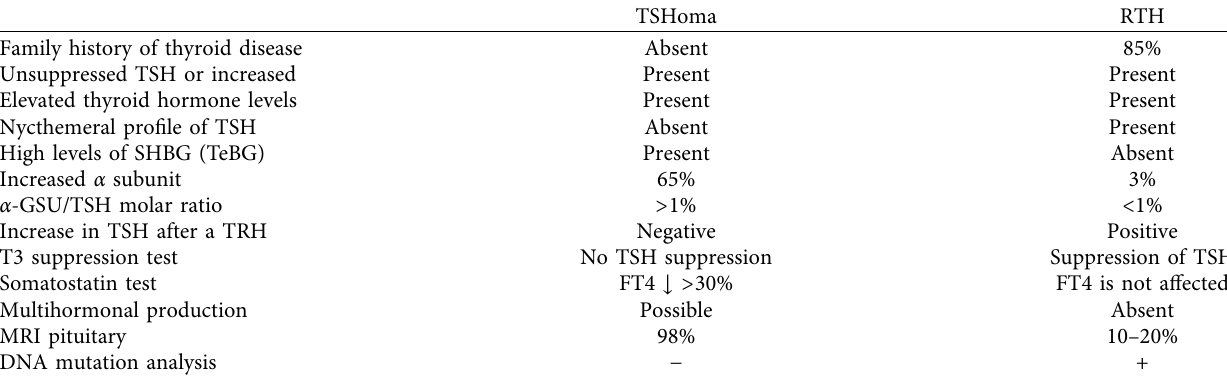
Table 3: The differential diagnosis markers between TSH-secreting adenomas (TSHomas) and resistance to thyroid hormones